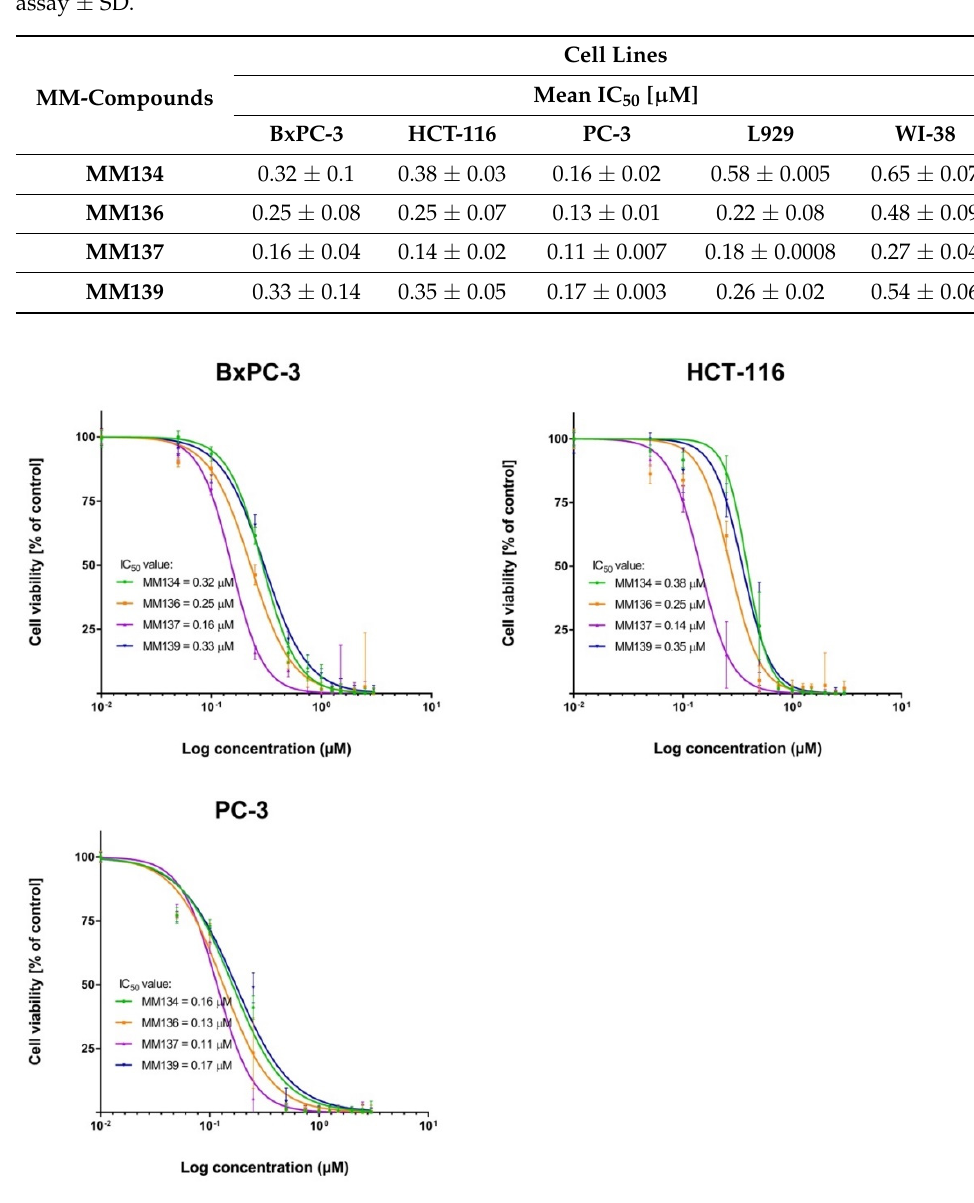
Figure 4. Determination of relative cancer cell viability of pancreas adenocarcinoma cell line (BxPC-3), colorectal carcinoma cell line (HCT-116) and prostate adenocarcinoma cell line (PC-3) treated with MM-compounds; ±SEM.